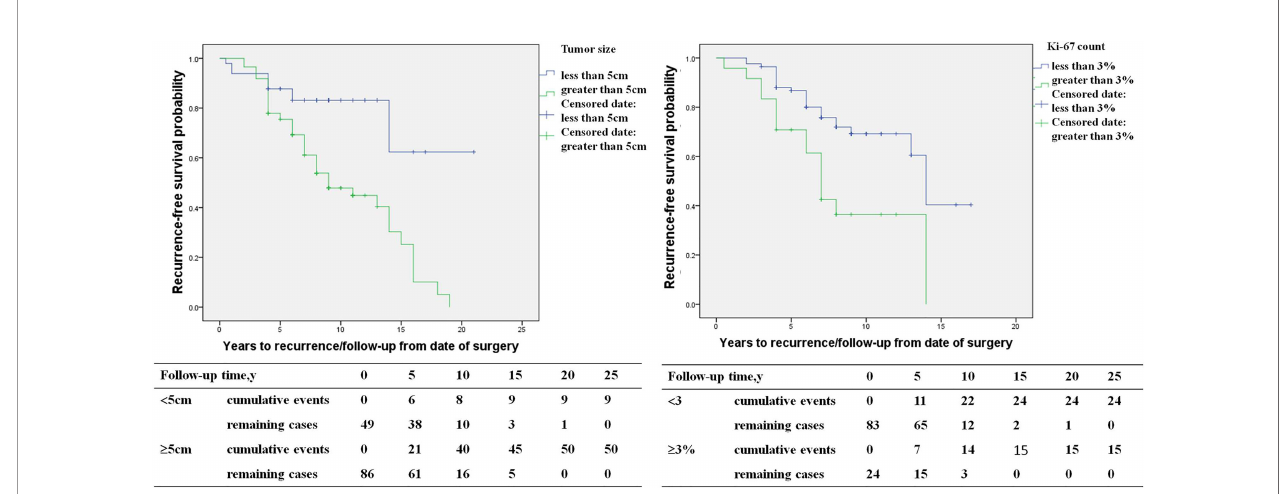
FIGURE 3 | The recurrence-free survival (primary tumor size <5 versus primary tumor size ≥ 5cm, average Ki-67 count <3% versus Ki-67 count ≥ 3%) in pheochromocytoma